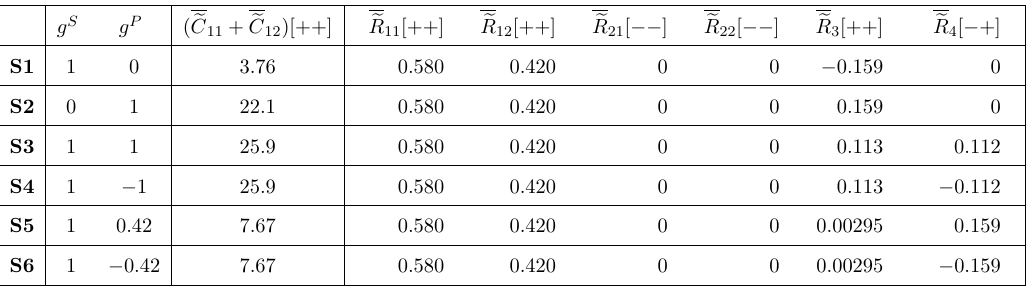
Table 2 . The values of e C 11 + e C 12 and the 6 angular observables e R i = e C i = ( e C 1 + e C 3 ) with i = 11 ; 12 ; 21 ; 22 ; 3 ; 4 taking w i = 1 for the 6 scenarios under consideration. The CP and CP e T parities of each observable are shown in the square